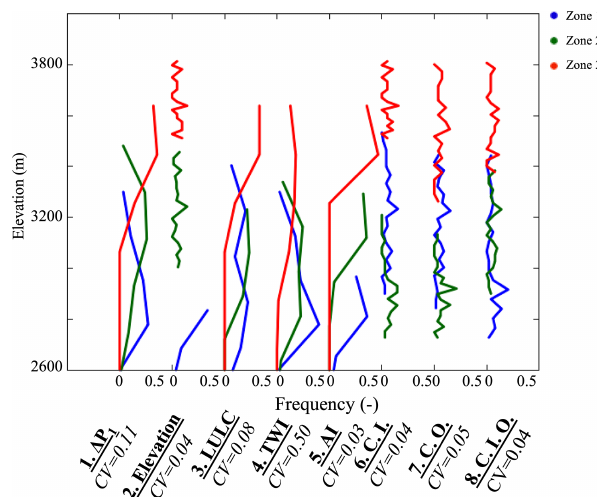
Figure 6. Frequency distributions of hillslope elevation. Cluster- ing approaches are based on (cid:49)P 1 , elevation, land cover (LULC), topographic wetness index (TWI), aridity index (AI), and machine- learning approaches (with inputs C.I., outputs C.O., and inputs and outputs C.I.O.). Hillslope clustering approaches are located across the x axis. Note that we plotted the distributions of the eight clus- tering approaches on the same graph and between each dotted line (with a frequency from 0 to 0.5), the frequency distributions of the three zones derived from the clustering are plotted.